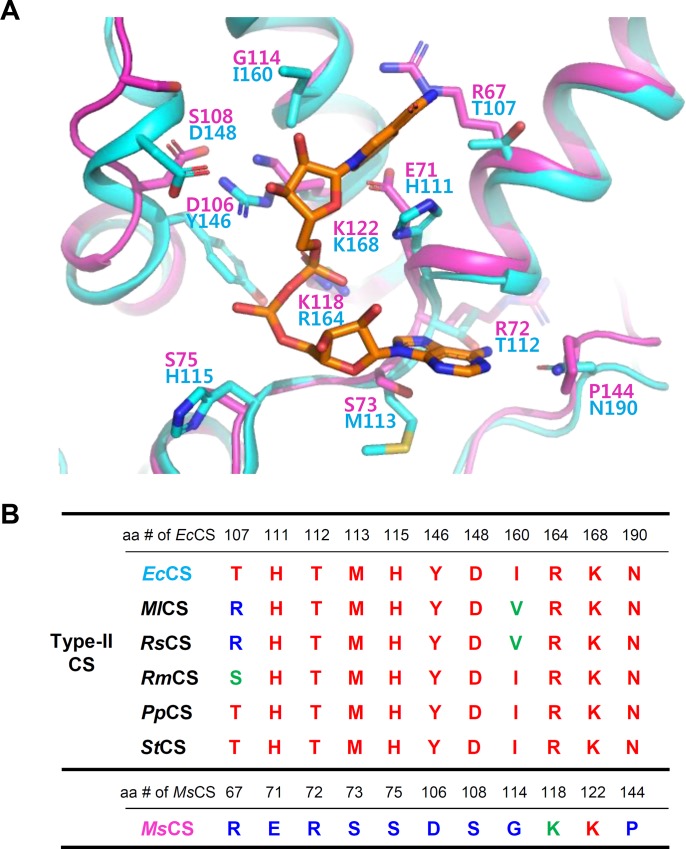
Structural and amino acid comparison of MsCS with other Type-II CSs.(A) Superposition of MsCS with CS from Escherichia coli (EcCS) in complex with the NADH inhibitor. The MsCS and EcCS are distinguished as magenta and light-blue colors, respectively. (B) Amino acid sequence alignment of key residues involved in NADH binding in EcCS and several Type-II CSs. MlCS, RsCS, RmCS, PpCS and StCS are representatives of CS from Methylomicrobium album, Rhodobacter sphaeroides, Ralstonia metallidurans, Pseudomonas putida, and Salmonella typhimurium, respectively. The colored amino acid are indicated to same (red), similar (green) and different (blue).